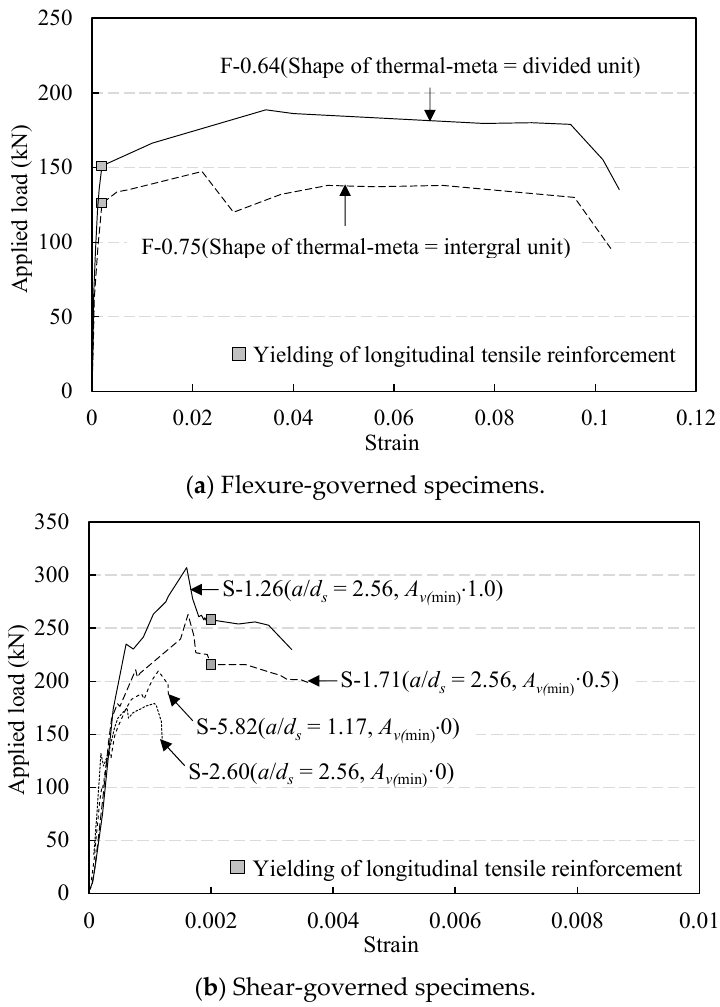
Figure 8. Strain response of longitudinal tensile reinforcing bars as a function of the applied loads.